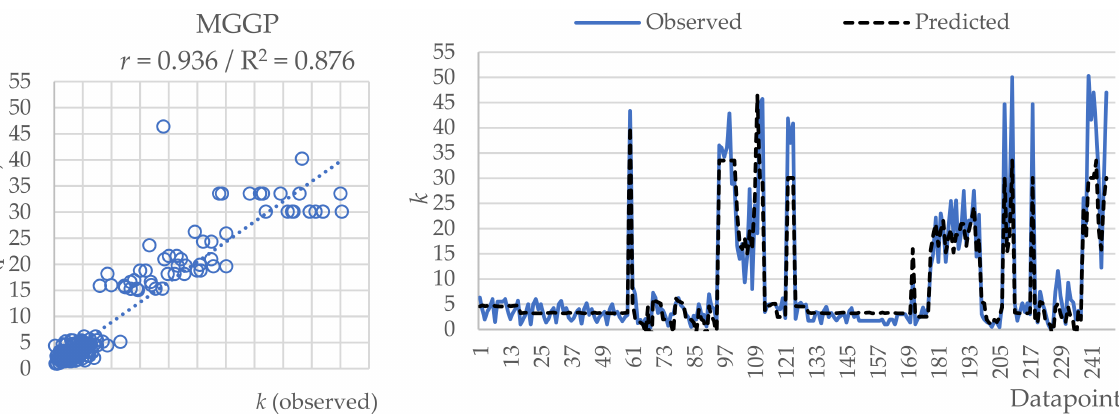
Figure 10. Scatter plot and hydrograph for RF model.